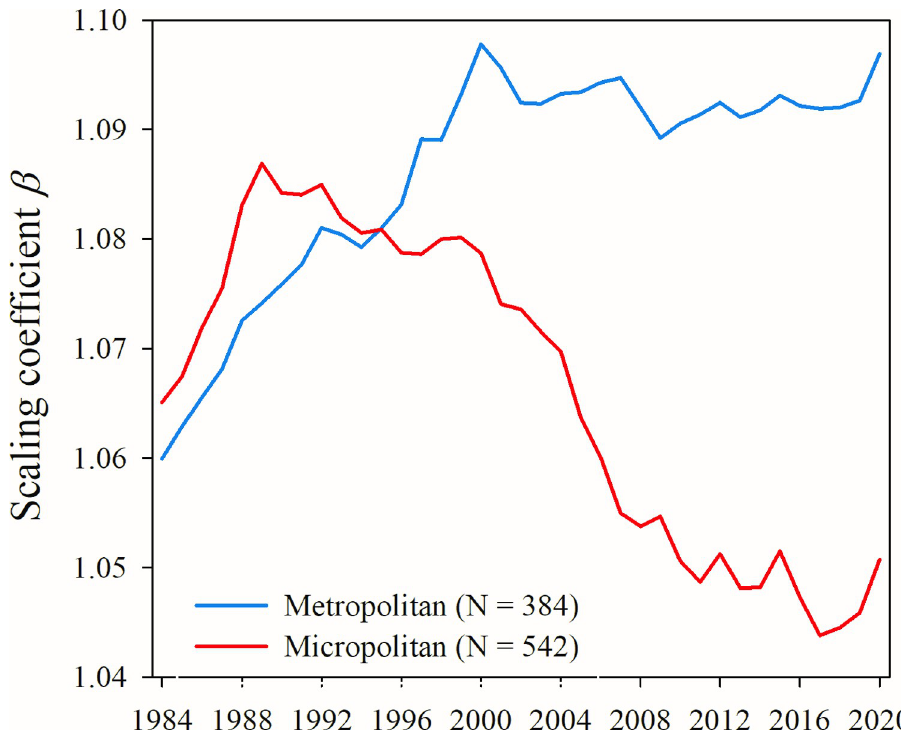
Fig 2. Metropolitan vs. micropolitan wage premium 1984–2020. We take the power function exponent β of log (wages) vs. log(employment) to be a measure of the urban wage premium for each area type. Wages here are not adjusted for regional differences in cost of living. See Supplemental Information for full table of results with confidence intervals.